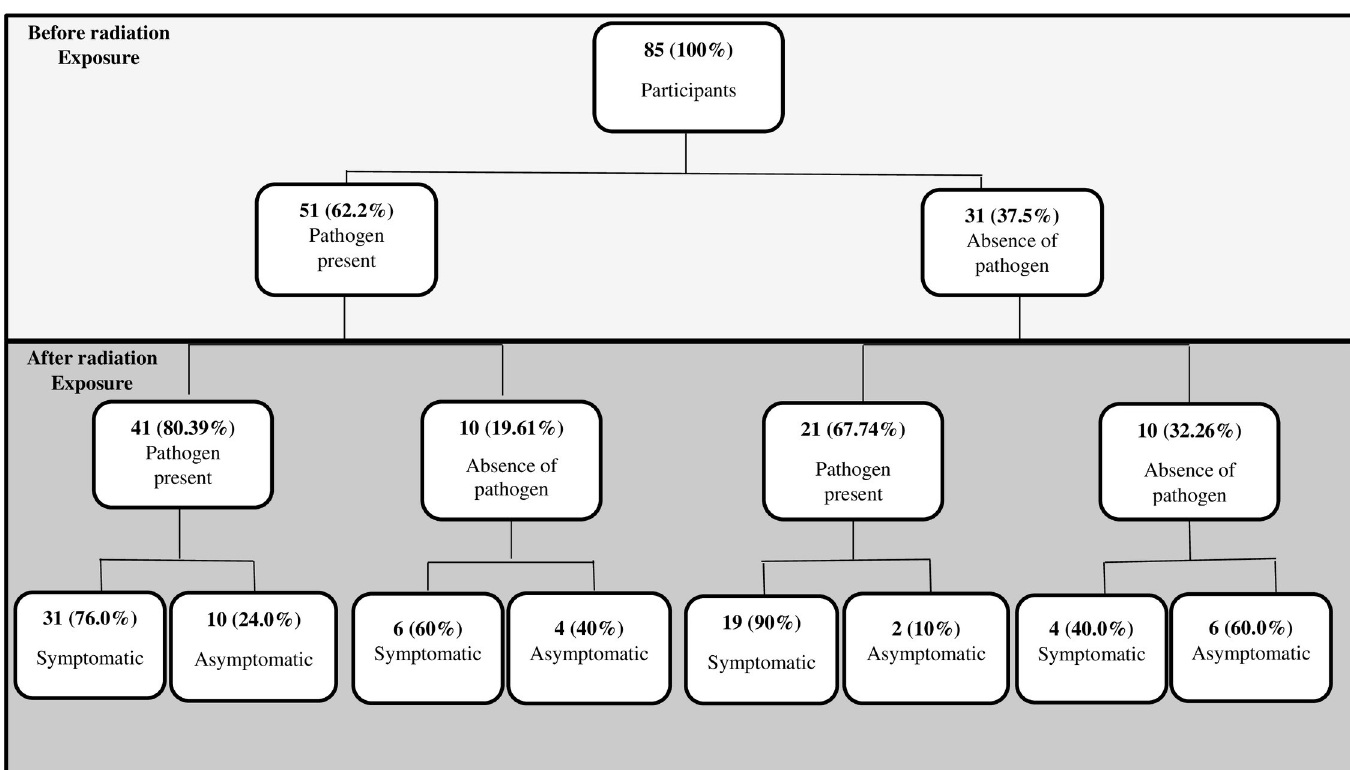
Fig 4. Presence or absence of respiratory pathogens before and after radiation exposure among cohort. Study population size (82); the 3 lost to follow up were excluded.